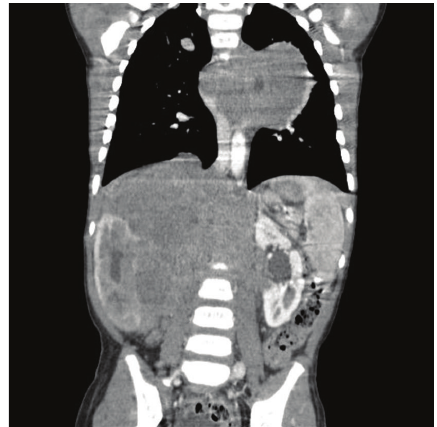
Figure 2: CT scan of abdomen and chest; large abdominal mass in right side and paravertebral mediastinal mass in left